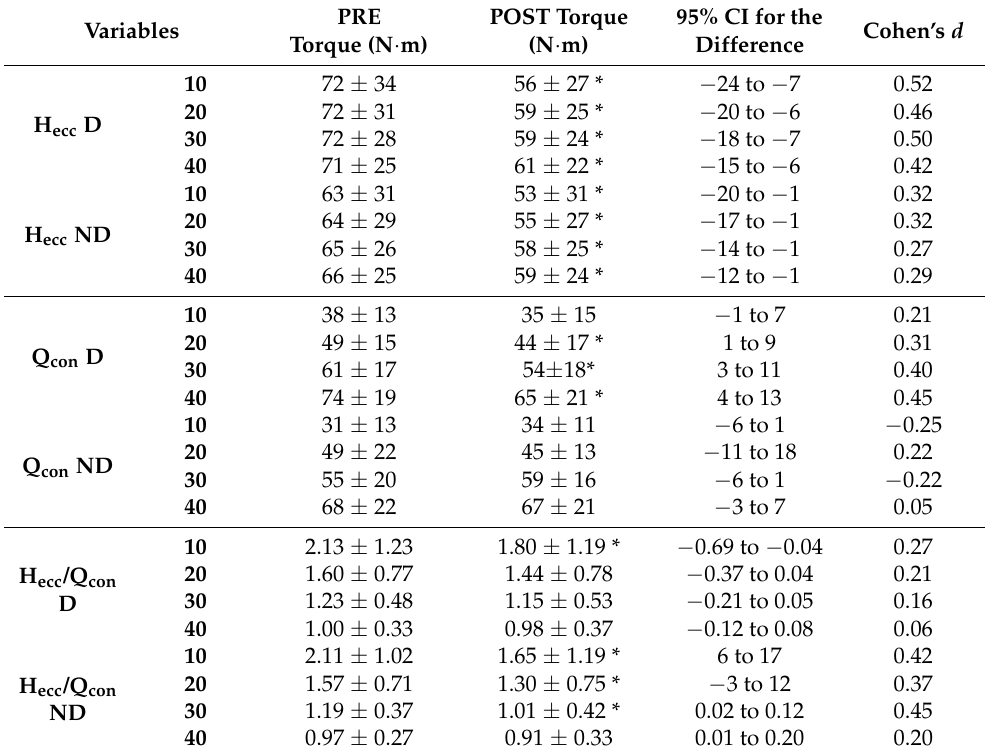
ecc : hamstring eccentric contractions, D: dominant leg, ND: non-dominant (ND)